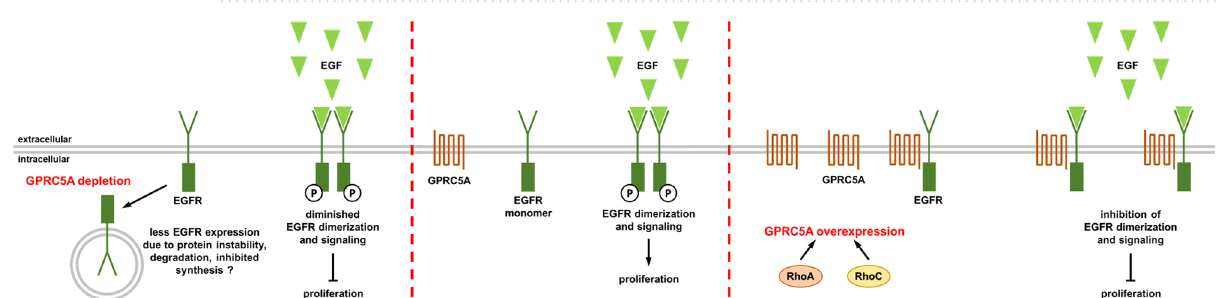
Figure 8. Model depicting various effects of GPRC5A on EGF-dependent proliferation. Under physiological GPRC5A expression it interacts with the unstimulated EGFR and stabilizes the protein at the cell membrane. After EGF stimulation the EGFR dissociates from RAI3 and forms dimers for activation of the kinase domain leading to further signal transduction (middle). When GPRC5A is overexpressed, it behaves like a dissociation inhibitor. Upon stimulation the EGFR monomers cannot form dimers. Less EGFR phosphorylation results in diminished proliferation (right). GPRC5A depletion results in downregulation of the EGFR and thereby inhibits proliferation. The mechanism has to be further investigated